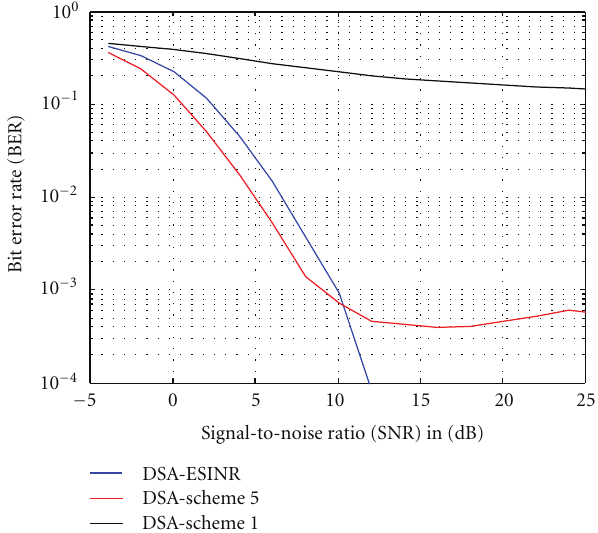
Figure 14: BER performance comparison for suboptimal allocation schemes in a fully correlated